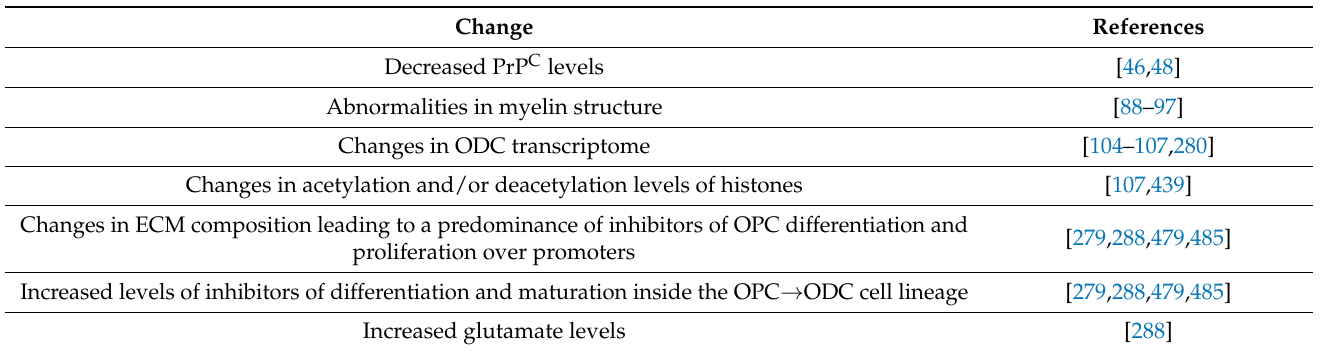
Table 1. A list of some changes in the MS CNS that are inconsistent with an autoimmune-mediated pathogenesis of